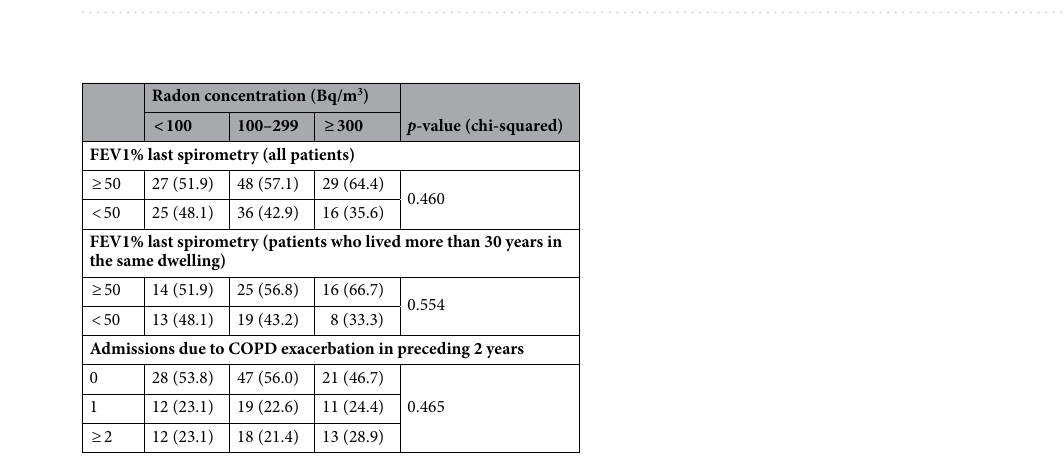
Figure 2. Residential radon concentrations by age.